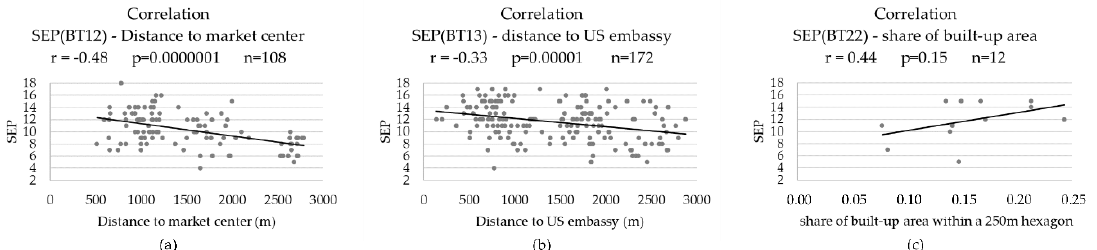
Figure 11. Identified effects of distance on SEP within building types to be disaggregated in Belmopan. For each relation ( a – c ) the correlation coefficient r is given, as well as statistical significance p and sample size n .